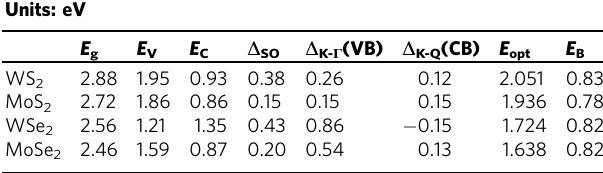
All parameters listed are experimentally addressed by electron tunneling and optical spectroscopy measurements with SC-mTMD-based planar heterostructures. Energy-level assignments have uncertainty levels